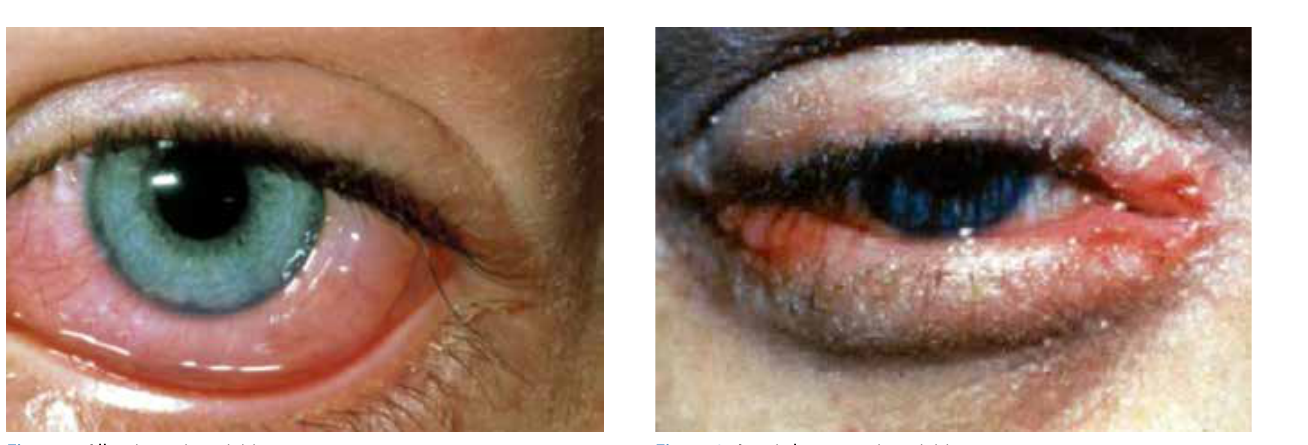
Figure 1: Allergic conjunctivitis Image available from http://www.newhealthguide.org/images/10420176/Allergic- Conjunctivitis.jpg